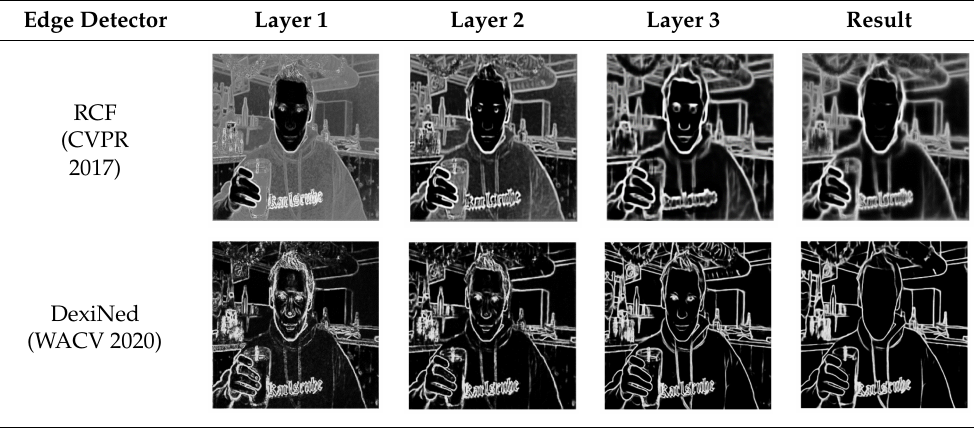
Table 2. Edge images generated by each edge detector for color image in Figure 2a.